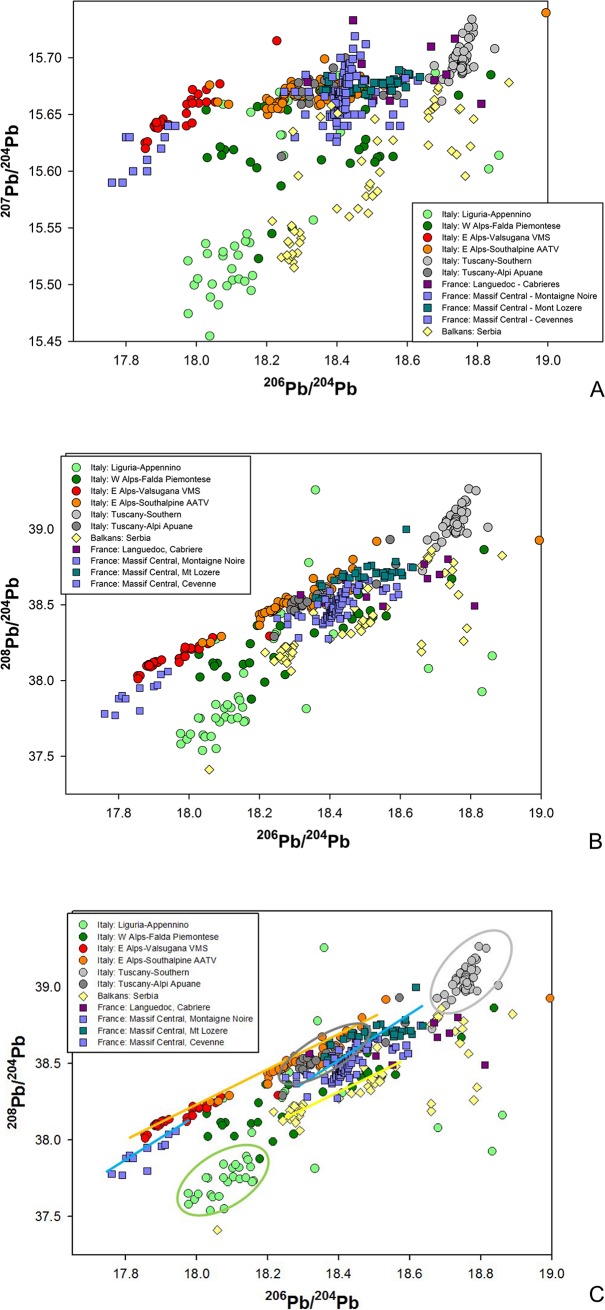
LI diagrams comparing the copper ore fields of central Italy with other major European ore fields; (a) 2D plot of 206Pb/204Pb vs 207Pb/204Pb LI data; (b) 2D plot of 206Pb/204Pb vs 208Pb/204Pb LI data; (c) 2D plot of 206Pb/204Pb vs 208Pb/204Pb LI data with marks showing ore fields (grey: Tuscany; pale green: Liguria-Apennine; dark grey: Apuanian Alps) and trend lines (orange: South-Eastern Alps; blue: Massif Central; yellow: Serbia).